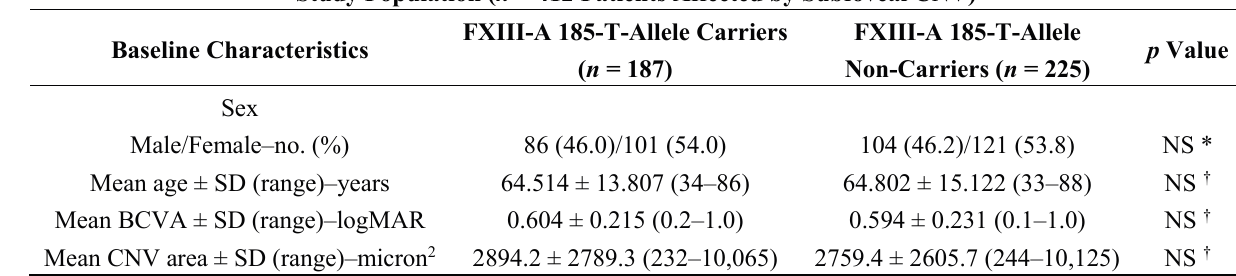
Table 1. At-baseline comparisons between demographic and clinical characteristics of factor XIII-A 185-T-allele carriers (patients with GT or TT polymorphic genotypes) and non-carriers (patients with wild-GG